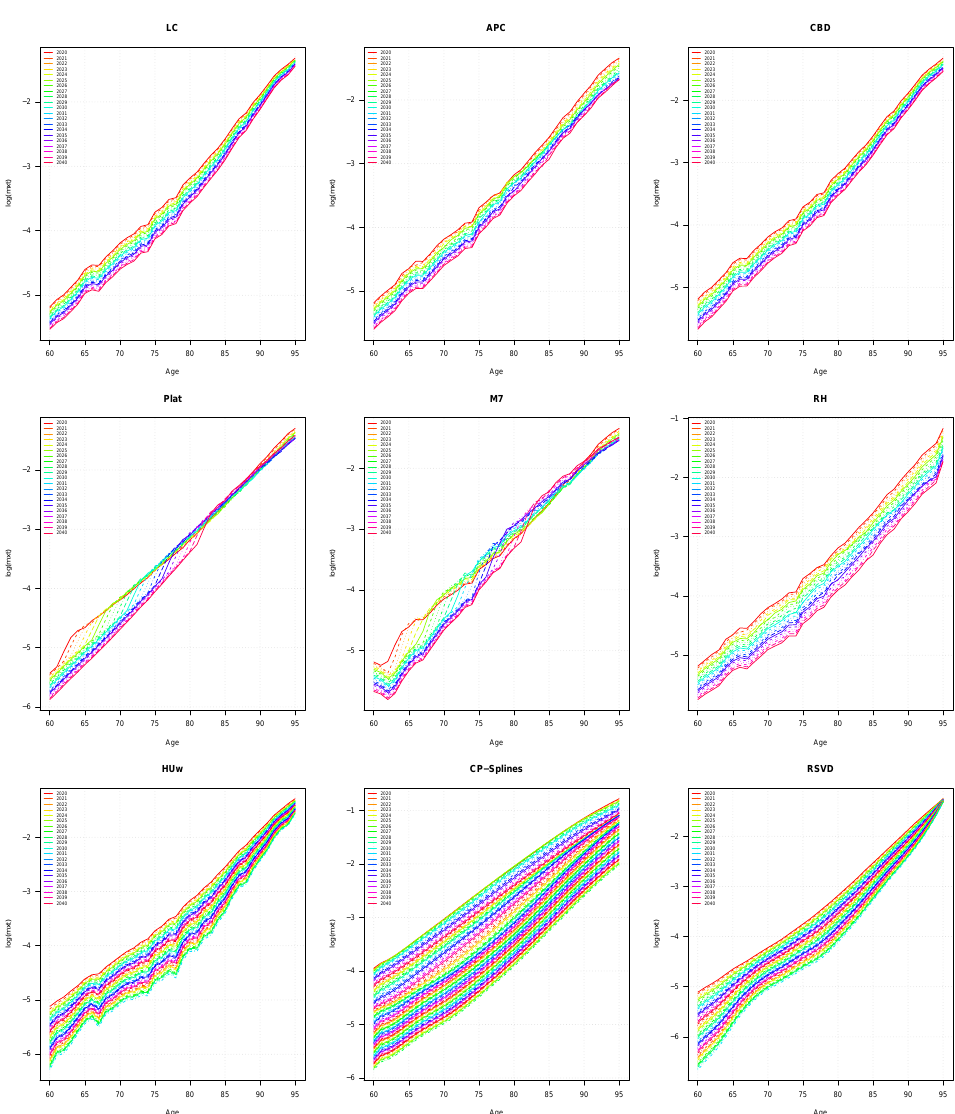
Figure 1. Stochastic mortality model forecasting results for selected years, Finland. Figure 2 plots, in the vertical axis, the subset of models selected by the BMA procedure—the model confidence set—for the total populations of Finland, Portugal, and Spain together with, in the horizontal axis, the corresponding BMA posterior probabilities (model weights). The results show that the set of best-performing forecasting models varies between countries, i.e., their predictive performance is population specific. This is explained by the differential patterns of age, time, and cohort effects in mortality observed in the data. The variability in out-of-sample forecasting accuracy of the models also reveals their ability to apprehend diverse features of mortality data. For instance, models with substantial age-period parameters, such as Plat and M7, tend to fit better the cross-section of the mortality curve, but exhibit poorer out-of-sample performance, often overfitting, whereas models with fewer age-period terms, such as LC and APC, tend to capture better the long-term trends in longevity and the annual noise in the data. The non-parametric approaches, such as CP-Splines and RSVD, tend to capture better nonlinearities in the data (e.g., the accident mortality hump at young ages). This means combining models is a way to leverage their strengths and minimize their downsides. The results obtained in this dataset show that no individual stochastic model dominates based on the